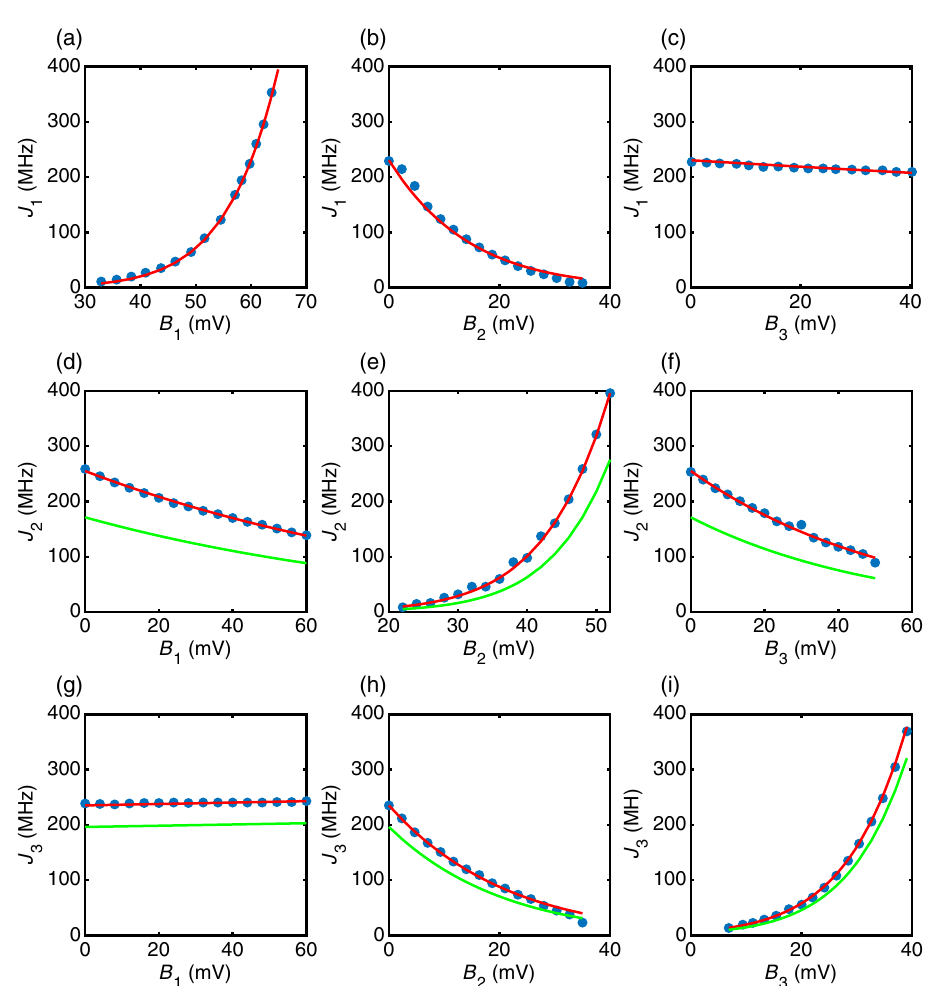
FIG. 4. Full calibration data, initial, and modified fits for the correct HL model. Blue data points are experimentally measured two- qubit exchange oscillation frequencies, red lines are correct HL model fits, and green lines are predicted frequencies using the model with modified parameters. To generate the modified parameters, we adjusted the HL parameters to generate voltages to match the voltages used in the three-spin exchange-oscillation experiment. We only adjust parameters for J 2 and J 3